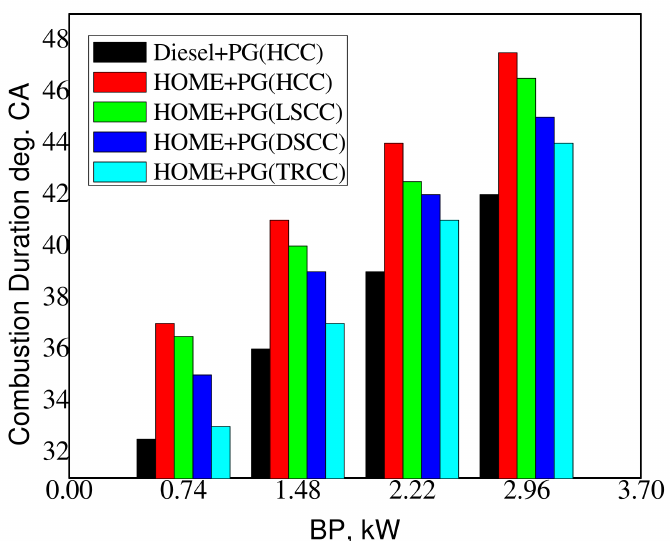
Figure 11. Effect of the combustion chamber type on combustion